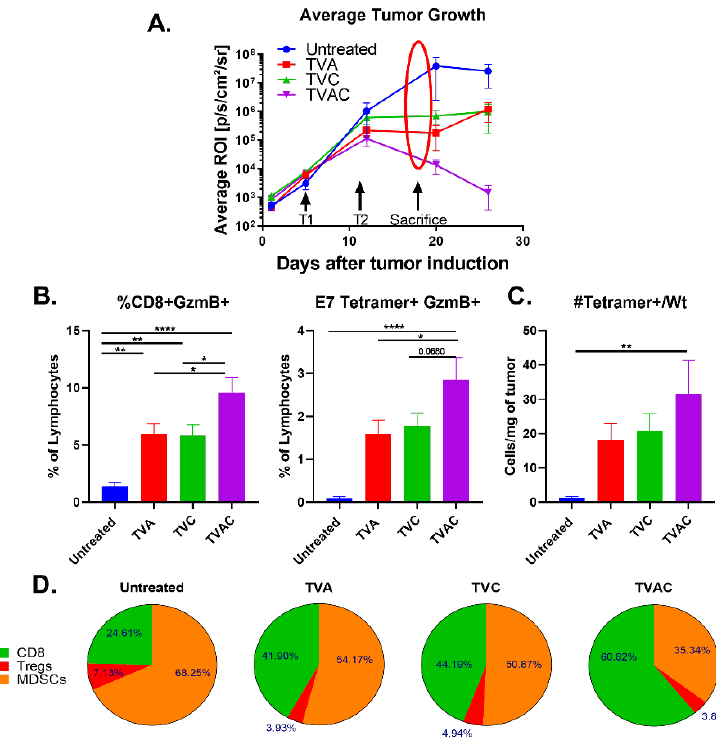
Figure 2. Increases in antigen-specific and overall CD8 T cell responses correlate with efficacy of the therapeutic HPV peptide vaccine. ( A ) Tumor infiltrating lymphocytes (TILs) isolated one week after the last immunization (marked with arrows and the oval) were analyzed by multi-parameter flow cytometry. ( B ) The frequency of granzyme B expressing (GzmB+) total and antigen-specific (E7 tetramer+) CD8 T cells are plotted as percent of live lymphocytes. ( C ) Numbers of antigen-specific CD8 T cells (E7 tetramer+) per milligram of tumor are shown. ( D ) Percentages of tumor infiltrating CD8+T cells, Tregs and myeloid derived suppressor cells (MDSCs) were calculated by dividing each population by the sum of CD8+Treg+MDSC counts per mouse and averaged by treatment group. Statistical significance between treatment groups was calculated via one-way ANOVA. p < 0.05 (*), p